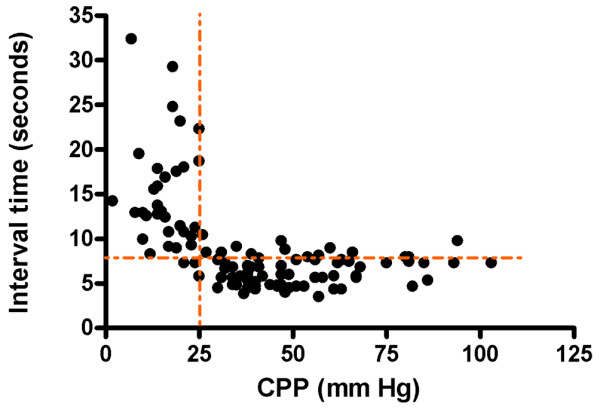
Cerebral perfusion pressure (CPP) and near infrared spectroscopy derived interval time. n = 76 measurements in 20 animals.